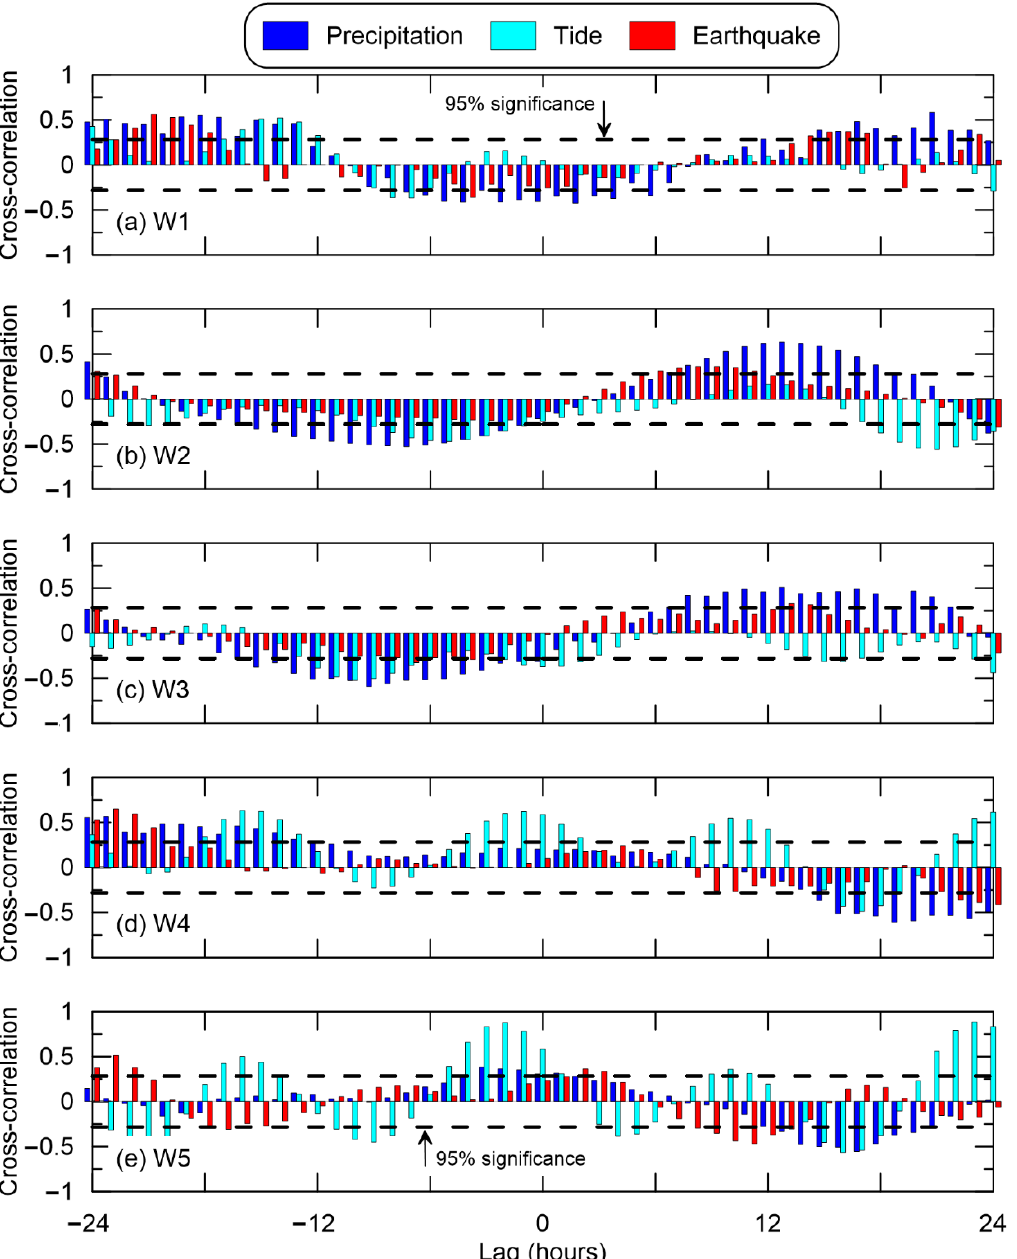
Figure 12. Cross-correlation analysis between groundwater levels in wells ( a ) W1, ( b ) W2, ( c ) W3, ( d ) W4, and ( e ) W5 against precipitation, tide, and earthquake, showing lag in hours one day before and after the main shock.